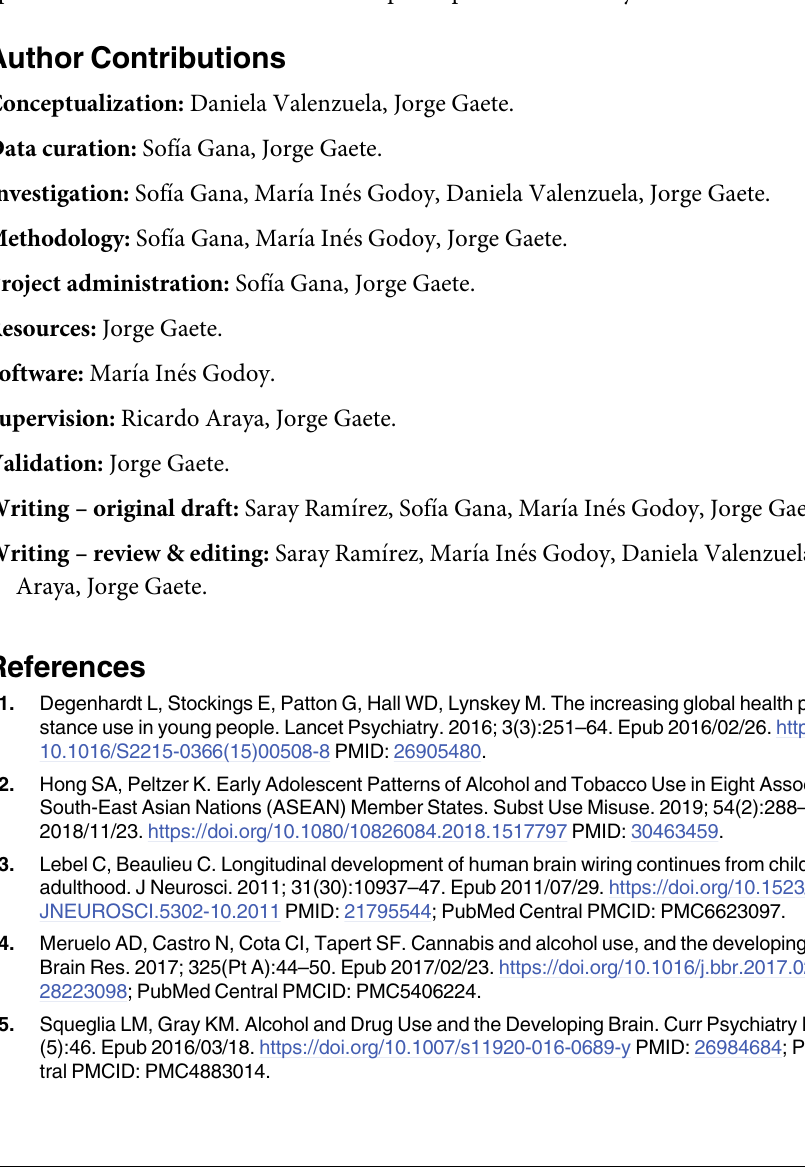
S1 Table. Family structure. S2 Table. Description of scales. S3 Table. Other risk and protective factors. S4 Table. Subscales correlations. S5 Table. Univariable associations of EU-Dap risk and protective and substance